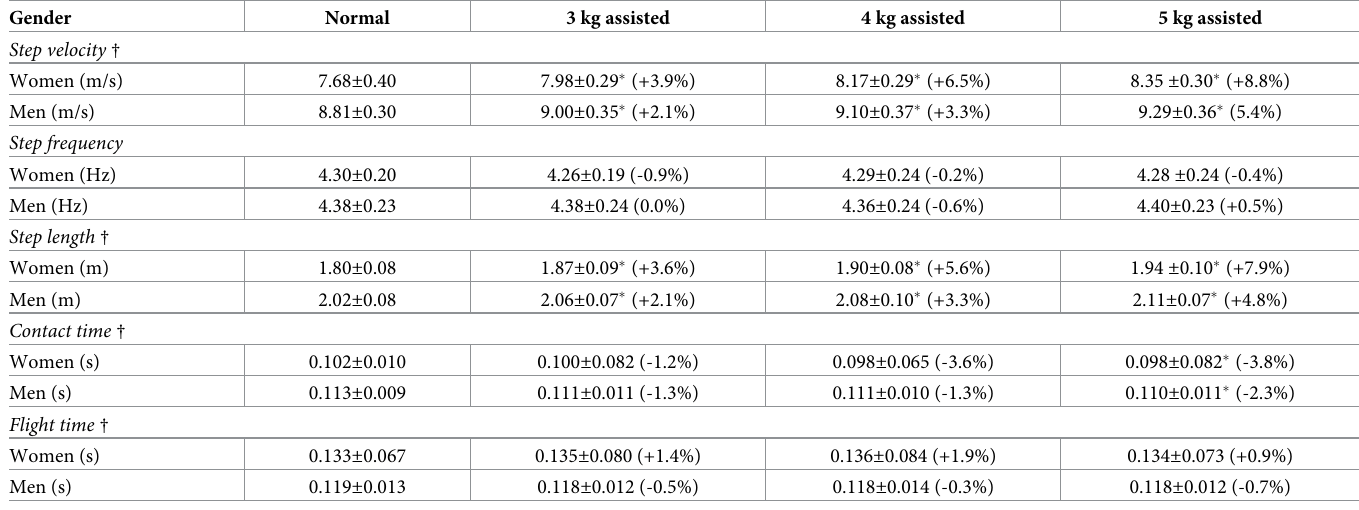
Post hoc comparisons revealed that men reached a higher step velocity and that they obtained this earlier (at 65–70% of the 60m) than women (75–80% of the 60m) for the different assisted conditions (Fig 3, Table 4). Men had longer step lengths, longer contact times, and shorter flight times than women (Figs 3 and 4). The assisted loads resulted in a higher step velocity with each increased assisted load in both men (+2.1–5.4%) and women (+3.9–8.8%) Fig 3). Step length increased with every assisted load for women (+3–7.9%) and for men between normal and 3 kg (+2.1%) and between 3 and 5 kg assisted loads (+4.8%, Fig 4). Con- tact times decreased significantly between 3 and 5 kg assisted sprints in women (-3.9%) (Fig 5), while post hoc comparison did not find a significant step frequency difference between conditions in women (Table 3). Step velocity was significantly different between conditions after 15% of the distance for both, while it increased further with larger assisted loads and lon- ger distances for women (70–80% of distance) than men (65–70% of distance). After reaching the maximal step velocity, maximal step velocity decreased again at 75% of the distance (45m) in a normal 60 m sprint in men to no reduction in step velocity with 5 kg assisted loads (Table 4 and Fig 3). In women, step velocity did not significantly decrease after reaching maxi- mal step velocity in the normal and 4 kg assisted sprints, while it deceased at 85 and 90% with 3 and 5 kg assisted loads (Fig 3, Table 4). Table 3. Average ( ± SD) step velocity, step length and frequency and contact and flight time over 60 m per condition with relative change per gender.